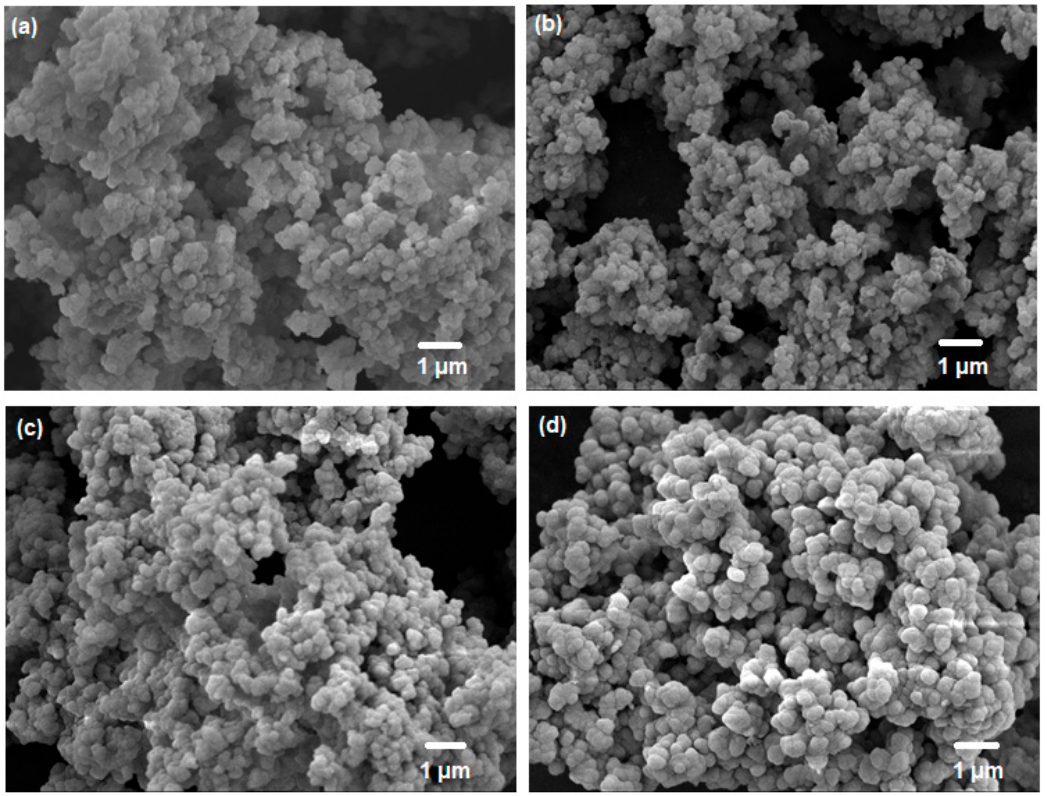
Figure 4. FESEM images of (a) UiO-66; (b) UiO-66-NH 2 ; (c) UiO-66-Br; (d) UiO-66-(OH) 2 .